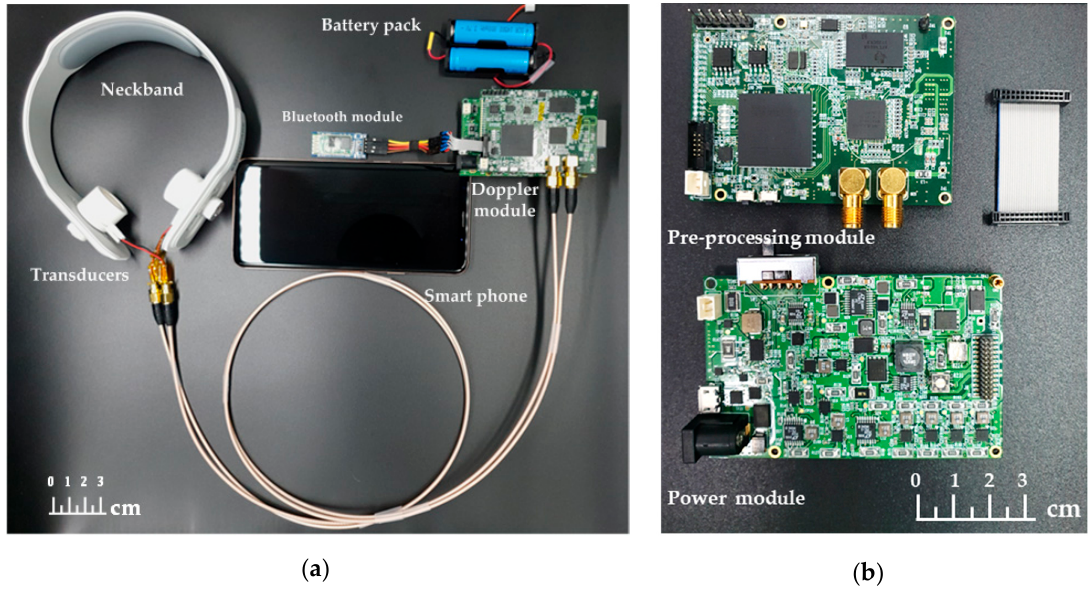
Figure 4. ( a ) Prototype of the wireless carotid wearable ultrasound Doppler system and ( b ) the pre-processing module and the power